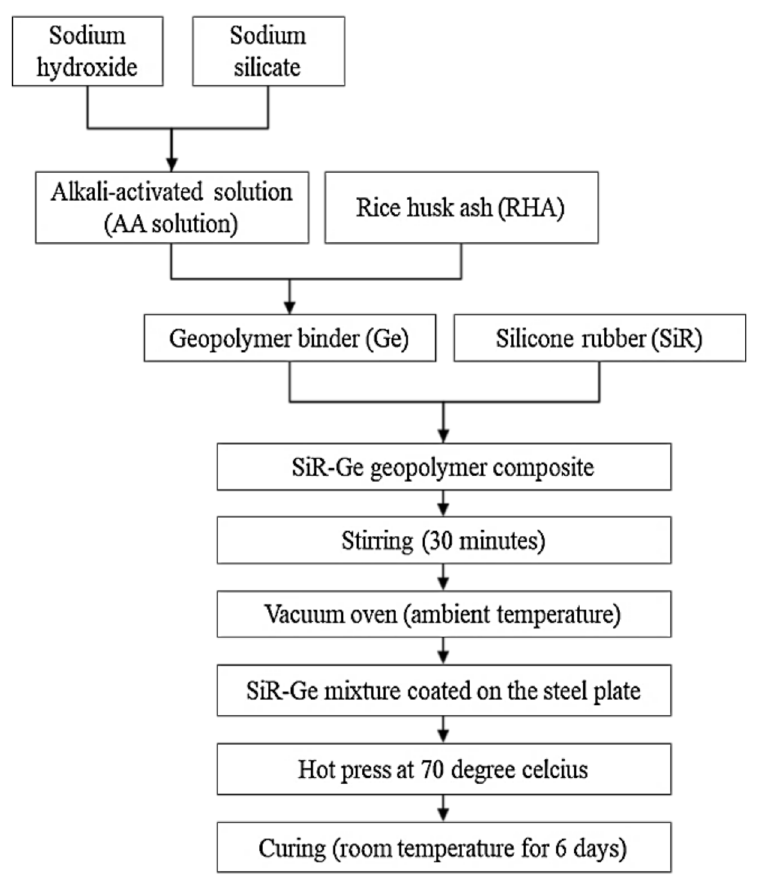
Figure 4. Flow chart for the fabrication of RHA/silicone rubber (SiR)-based binary blended geopoly- mer coating composite.